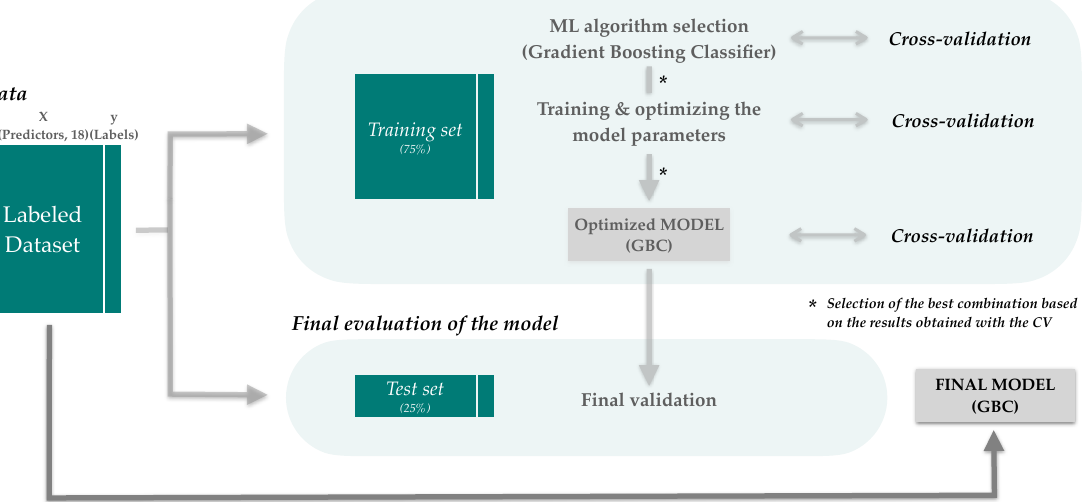
Figure 3. Model generation process. The labeled dataset, composed for a total of 1527 DVGs, between true positives ( TP = 764) and false positives ( FP = 762), was divided into two separate partitions of data (train and test set), respecting the proportion of the two categories. A GBC was chosen for training the model based on its best performance with respect to other algorithms such as Logistic Regression, Extra Trees Classifier, Supporting Vector Machine, and Random Forest. The optimization of the hyperparameters was achieved by the RandomizedSearchCV function of sklearn library using the training dataset. The optimized model was finally validated on the unseen test dataset considering that the model was generalizable. Finally, the model was trained with the totality of the data and integrated in the Predictive module of